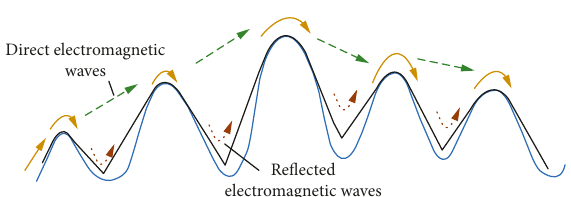
Reflected electromagnetic